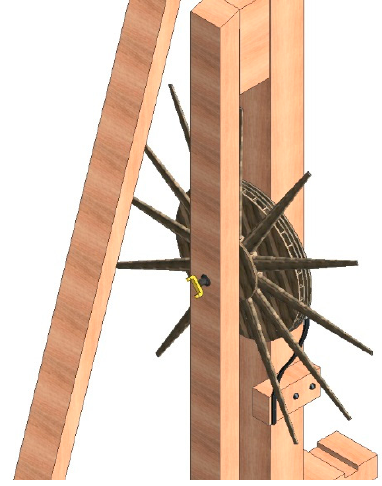
Figure 9. Detail of the winch.